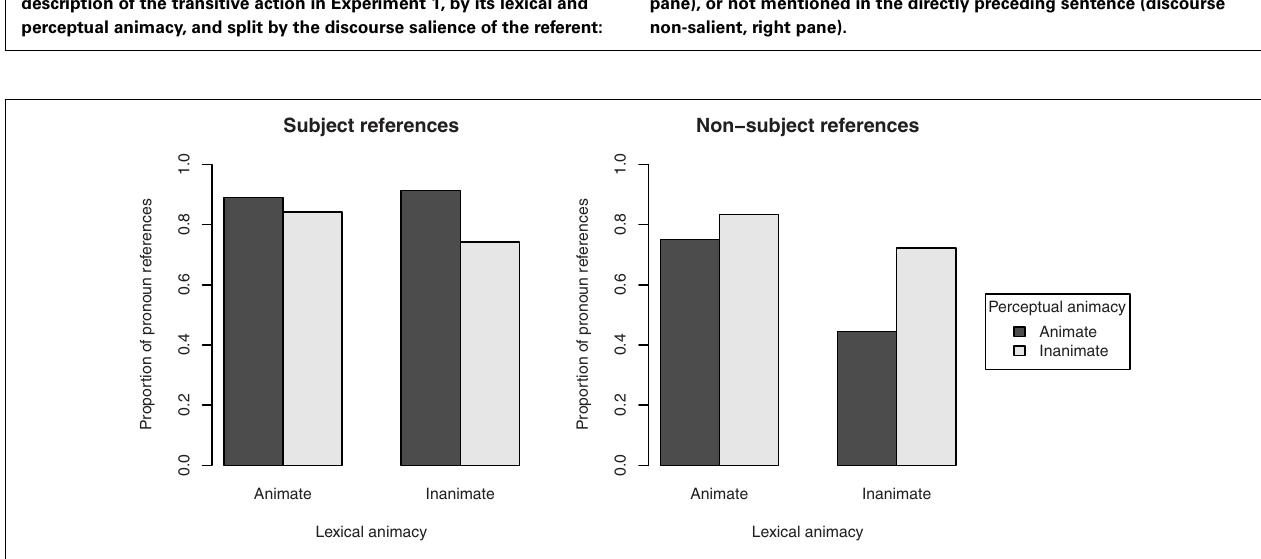
FIGURE 6 | Proportion of pronoun references to the target figure in the description of the transitive action in Experiment 1, by its lexical and perceptual animacy, and split by the grammatical function of the referent: subject (left pane), or non-subject (right pane).